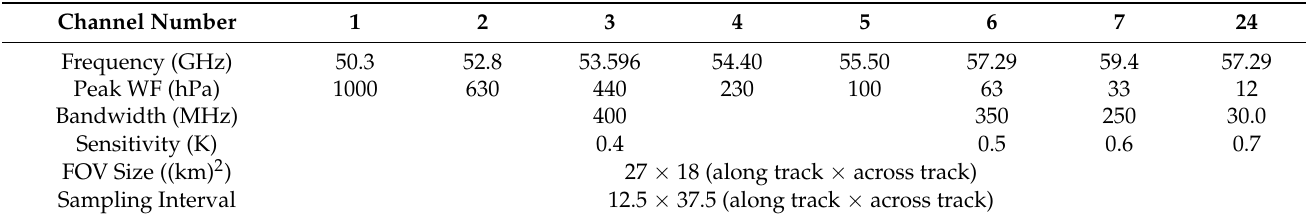
Table 1. The LAS channel